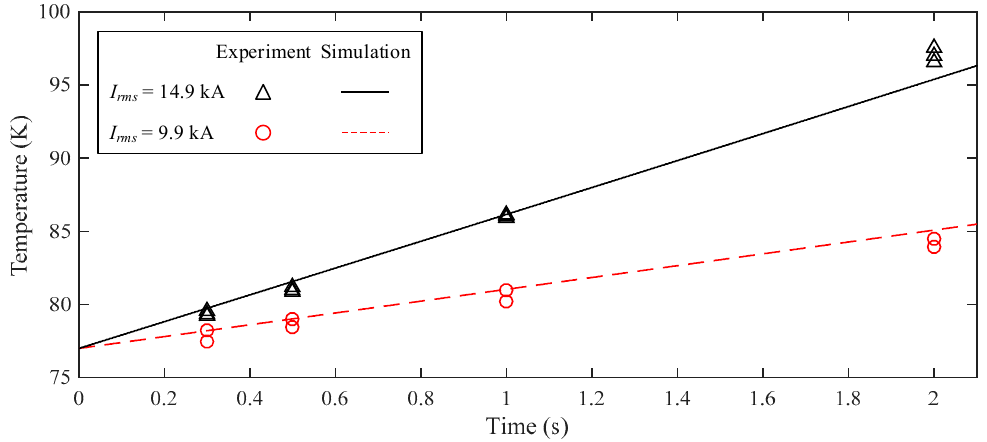
Figure 8. Comparison of Cu-former temperatures between experiment and simulation results.